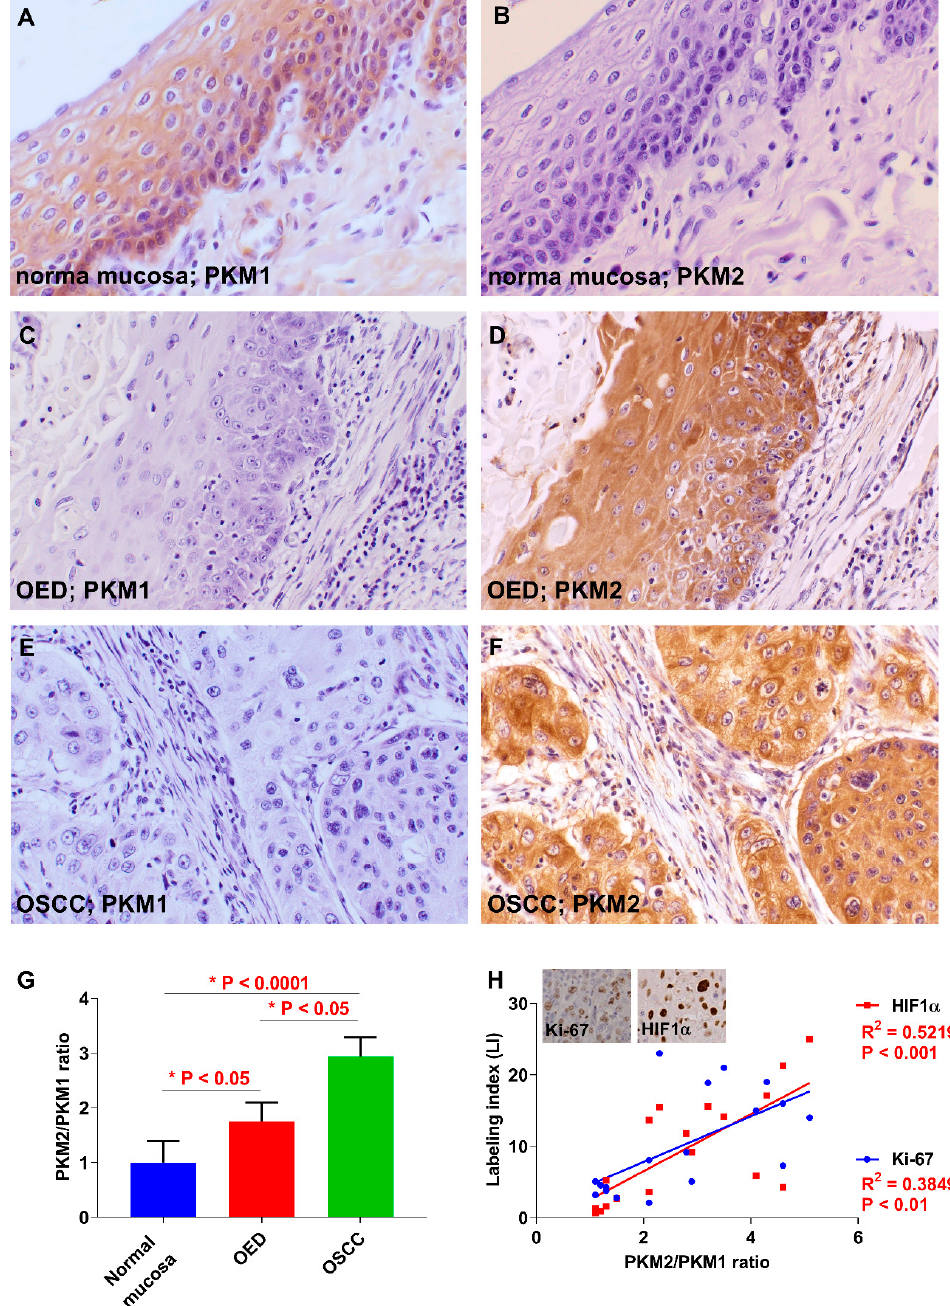
Figure 1. Expression of pyruvate kinase M1 (PKM1) and PKM2 in oral squamous cell carcinoma (OSCC) patients. ( A ) Immunoreactivity to PKM1 is observed in normal oral mucosa adjacent to OSCC. Weak or no expression of PKM1 in oral epithelial dysplasia (OED) ( C ) and OSCC ( E ). ( B ) PKM2 expression was not observed in normal mucosa adjacent to OSCC. Expression of PKM2 was detected in OED ( D ) and OSCC ( F ). ( G ) The PKM2/PKM1 ratio in OSCC cases is lower than in the normal mucosa adjacent to OSCC and in OED. ( H ) The PKM2/PKM1 ratio is closely related to Ki-67 and hypoxia inducible factor 1, the alpha subunit (HIF1 α ) index in OSCC specimens. Inset shows the expression of Ki-67 and HIF1 α . Original magnification is 400×.